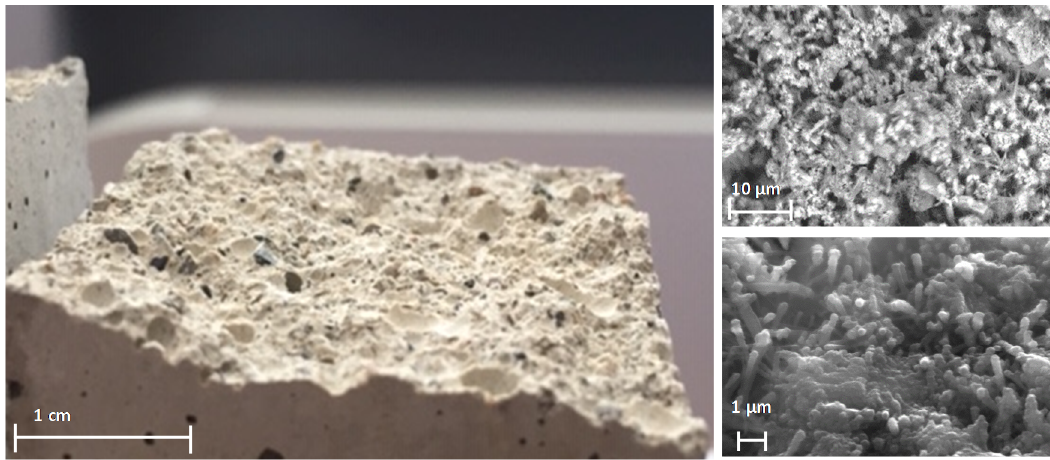
Figure 1. Photograph and SEM images of cement mortar specimens from our laboratory. Texture and porosity at various scales can be appreciated.